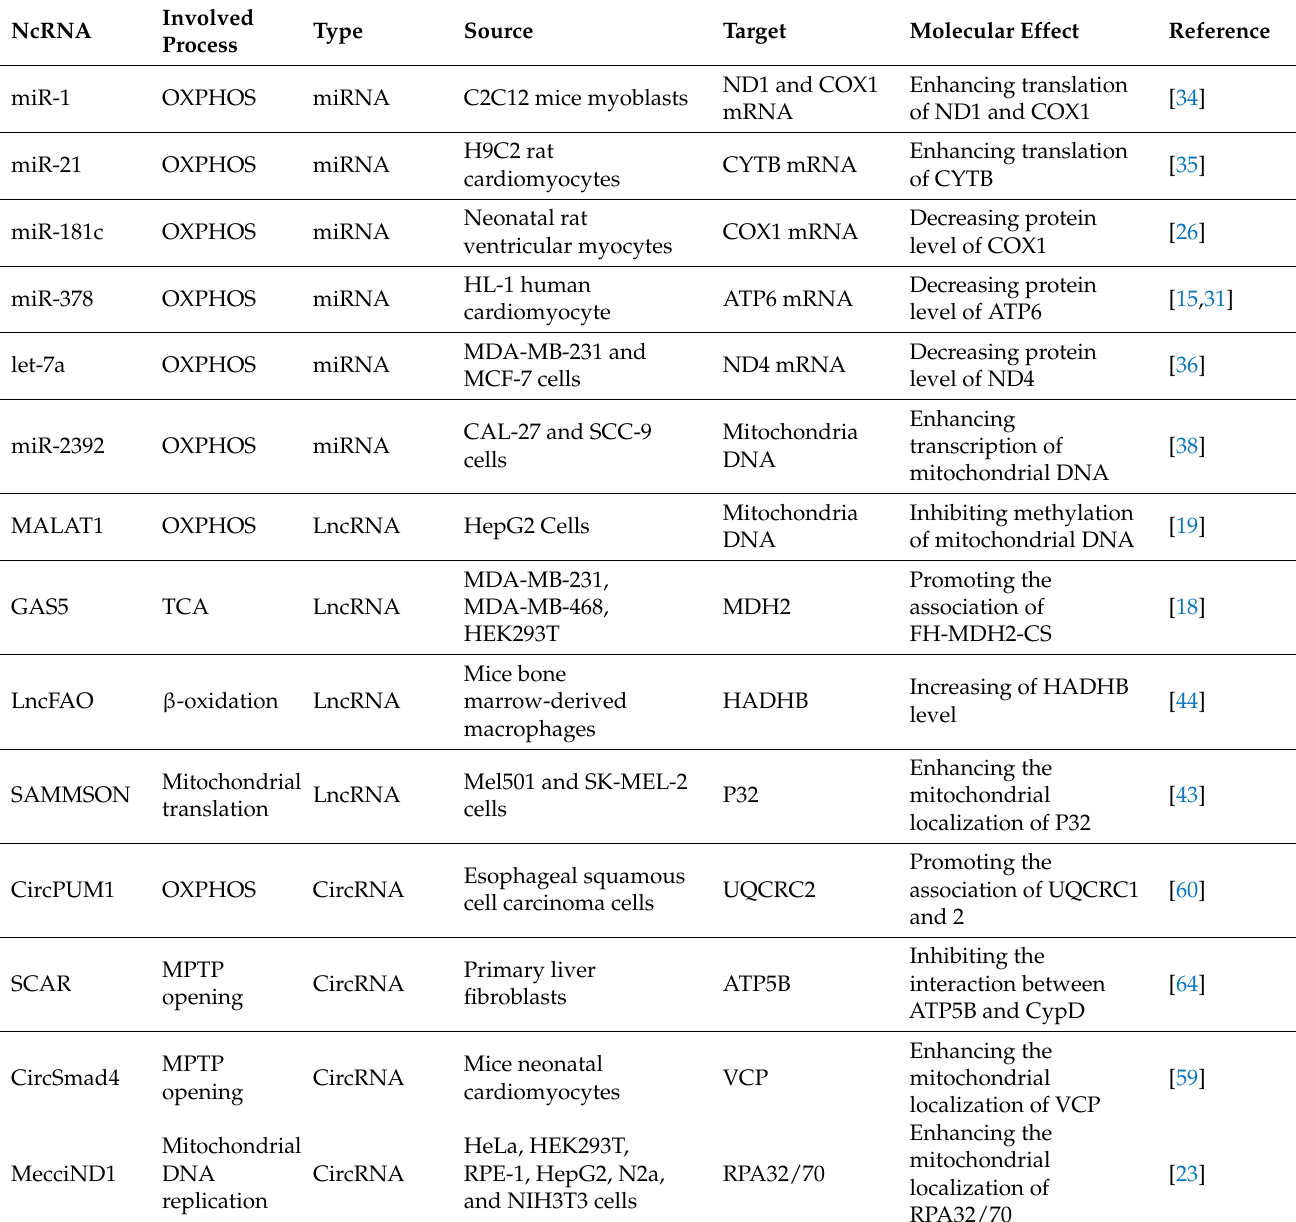
Table 2. Functional ncRNAs identified in